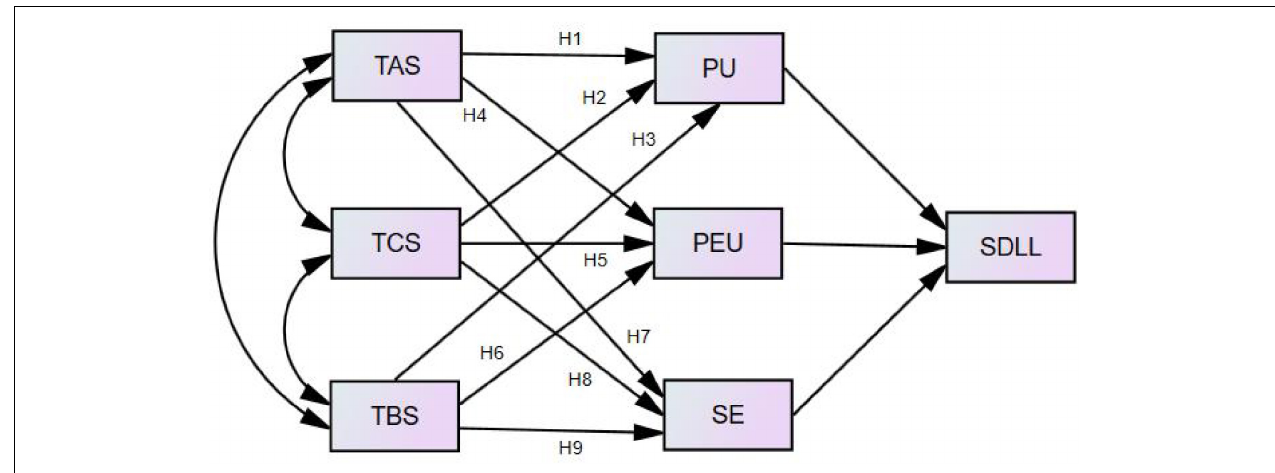
FIGURE 1 | The hypothesis